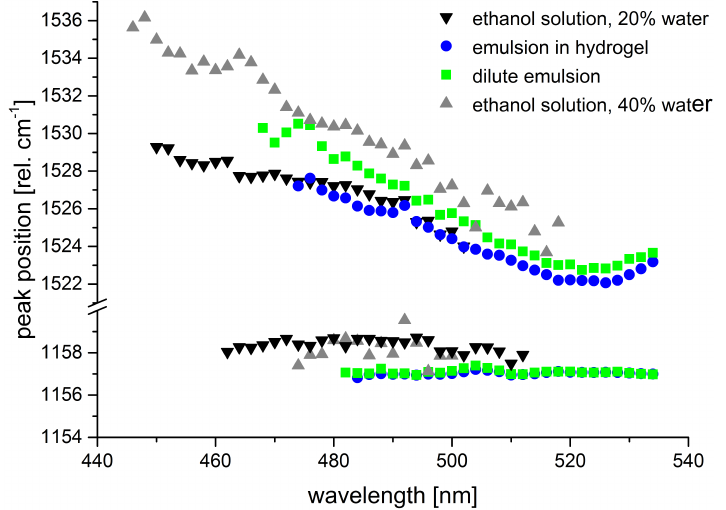
Figure 12. Peak positions of the C-C (1157 cm − 1 ) and C=C (around 1528 cm − 1 ) vibrations of β -carotene in different molecular environments, i.e., for the same samples as in Figure 11. Please note that all spectra were spectrally calibrated to the C-C vibration at a Raman shift of 1157 cm − 1 due to lack of a common external standard. Therefore, peak-to-peak distances but not absolute peak positions are reliable (reproduced with permission from